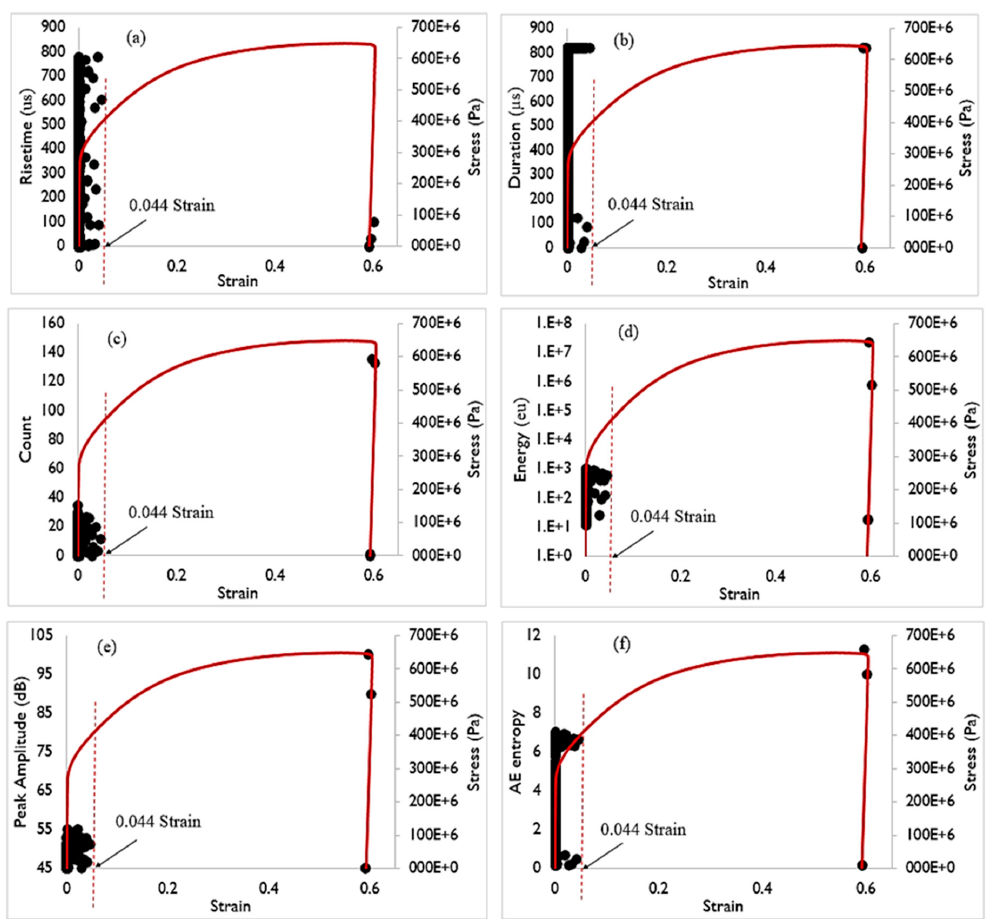
Figure 16. Validation of AE features with material response for the tensile specimen: ( a ) rise-time, ( b ) duration, ( c ) count, ( d ) energy, ( e ) peak amplitude and ( f ) AE entropy.